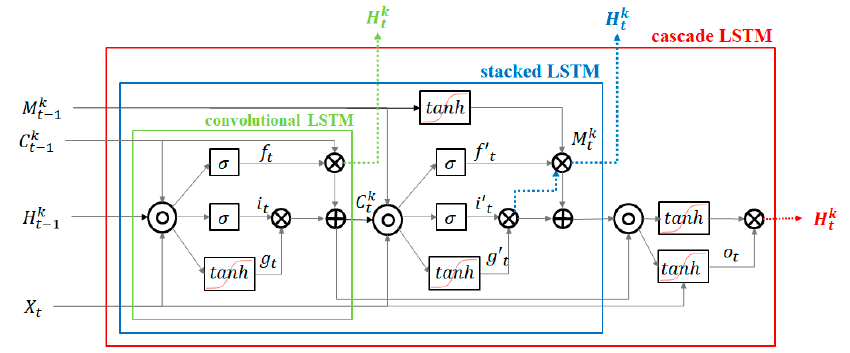
Figure 7. Structural di ff erences of convolutional LSTM, stacked LSTM, and cascade